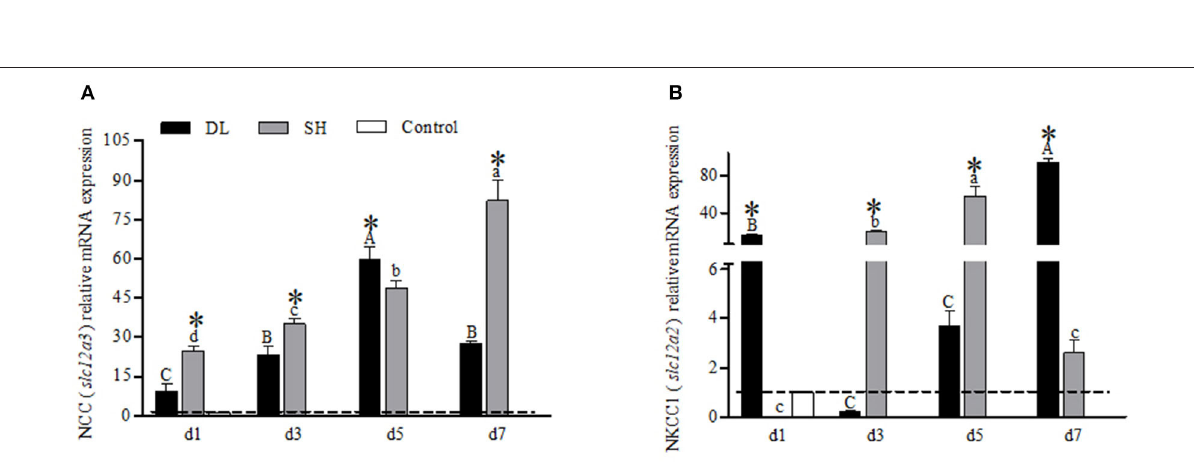
FIGURE 5 | Gill NBC1 ( slc4a4 ) and AE1 ( slc4a1 ) mRNA levels ( n = 3) for DL (the alkali form introduced from Lake Dali Nor) and SH (the freshwater form introduced from Songhua River) fish forms. Different uppercase letters indicate significant differences within DL, and different lowercase letters indicate significant differences within SH. The asterisk (*) denotes a significant difference found in the NBC1 or AE1 mRNA levels between DL and SH exposed to bicarbonate AW.